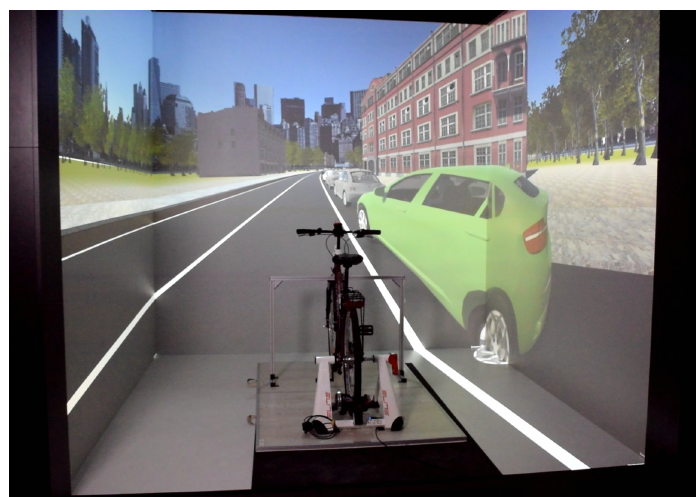
Figure 3. A picture of the bicycle simulator setup in the